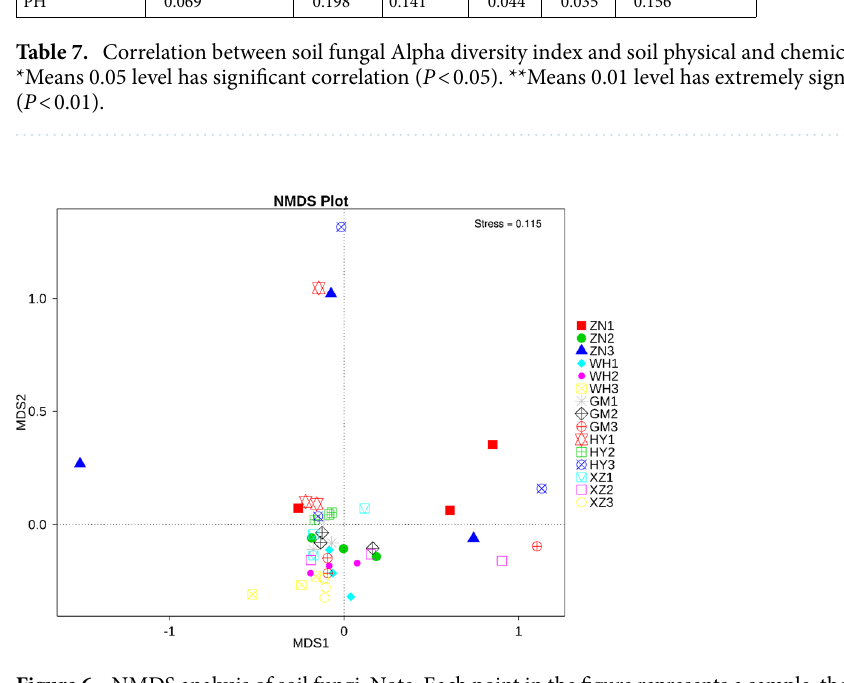
Figure 6. NMDS analysis of soil fungi. Note: Each point in the figure represents a sample, the distance between points indicates the degree of difference, and the samples in the same group are represented by the same color. When Stress is less than 0.2, NMDS can accurately reflect the difference between samples. The abbreviations ZN, XZ, HY, WH, GM represent the soil sample groups with the grape planting years of 5, 8, 10, 12 and 15, respectively, and the numbers 1, 2 and 3 represent the soil depths of 5–20 cm, 20–35 cm and 35–50 cm,